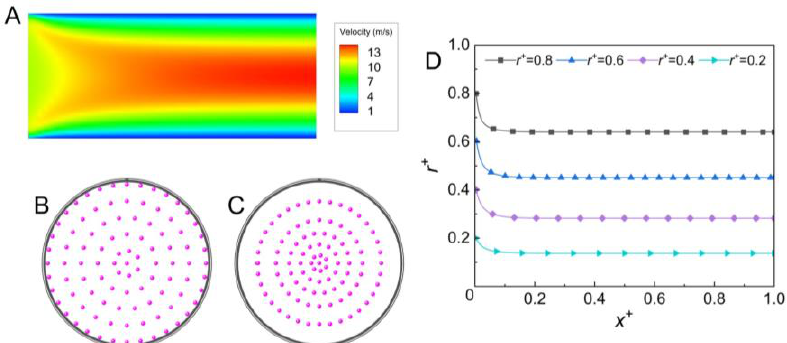
Figure 3. ( A ) Contour of the velocity in the x direction in the straight cylindrical microchannel; ( B , C ) distributions of the aerosol particle at the inlet and outlet of the straight cylindrical microchannel without external force, respectively; ( D ) particle trajectory in the microchannel without external force (the particles were released from r + = 0.2, 0.4, 0.6, and 0.8, respectively; u = 10 m/s, d p = 1 μm, ρ p = 1550 kg/m 3 ).